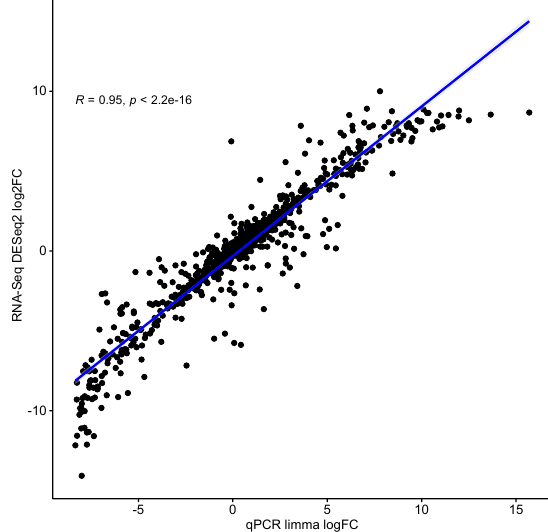
Figure 5. Logarithmized fold change correlation between limma results of qRT-PCR and the pipeline results ( DESeq2 ) of RNA-Seq data filtered by adjusted p -value ≤ 0.05 of limma results. The correlation was calculated by the Pearson